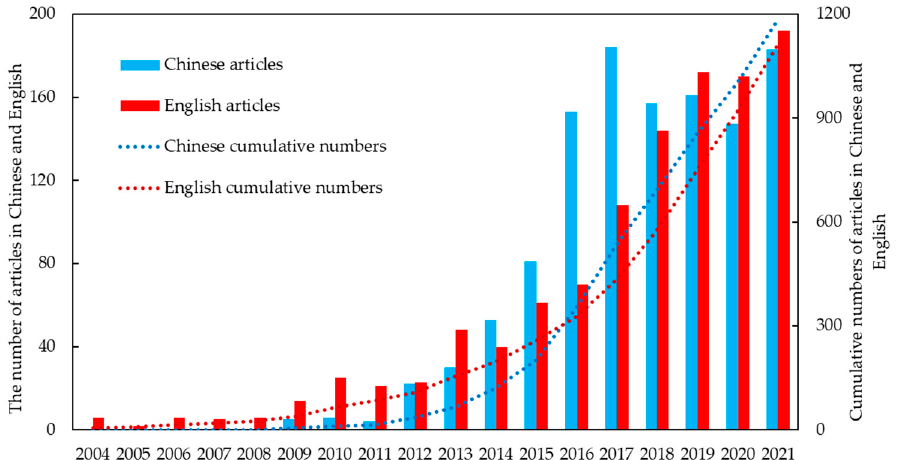
Figure 1. The number of published papers on the LID framework research from 2004 to 2021.